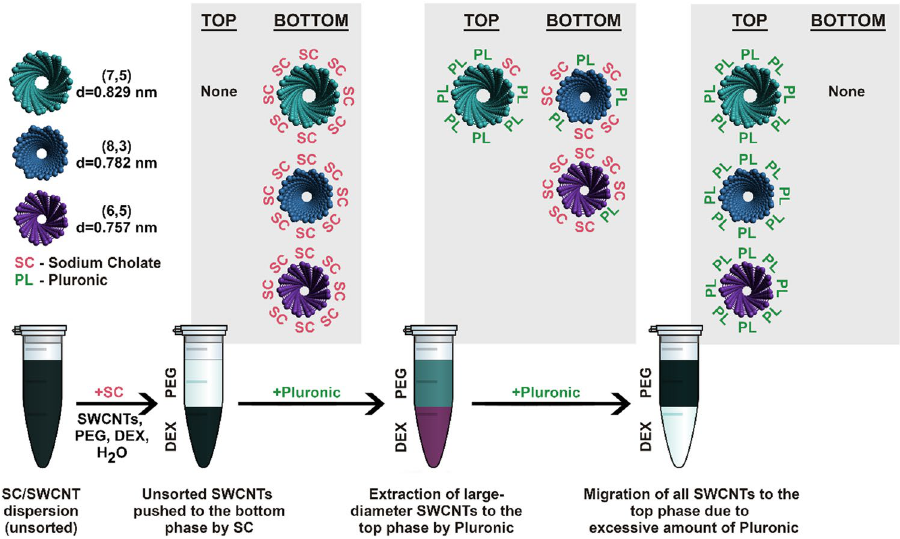
Figure 4. Differentiation of SC-dispersed, (6,5)-enriched SWCNTs sorted by ATPE upon varying the added volume of Pluronic in the presence of additional SC. SWCNTs were modeled by Avogadro: an open-source molecular builder and visualization tool 50